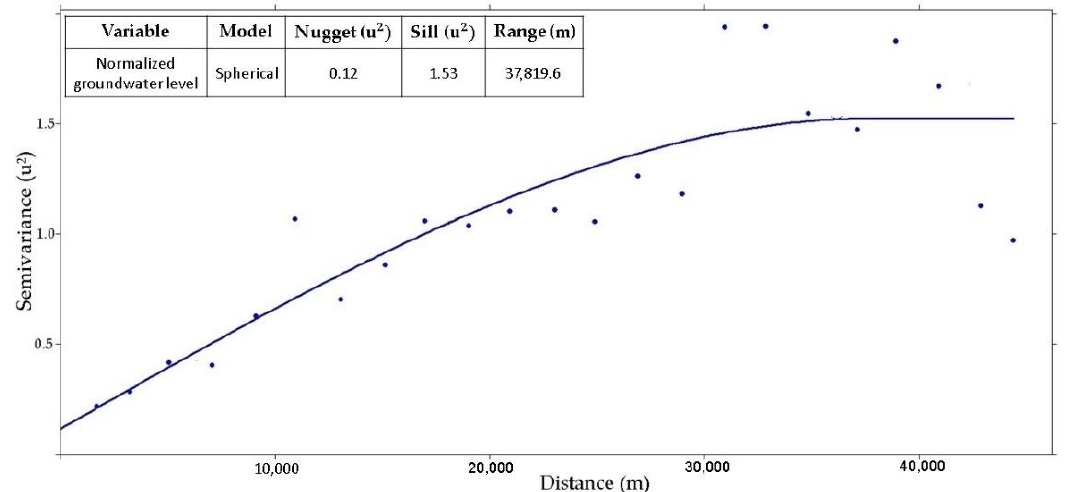
Figure 4. Sample variogram and adjusted model.